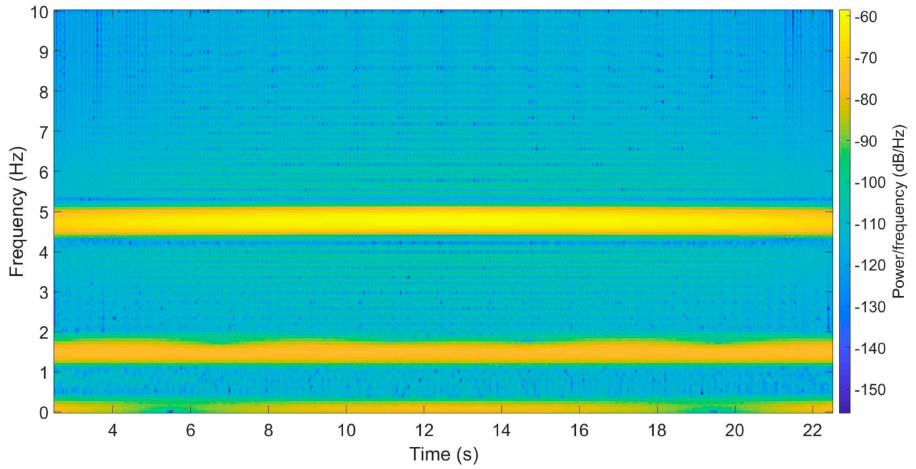
Figure 6. Short-time Fourier transformation of the healthy bridge accelerations with window size